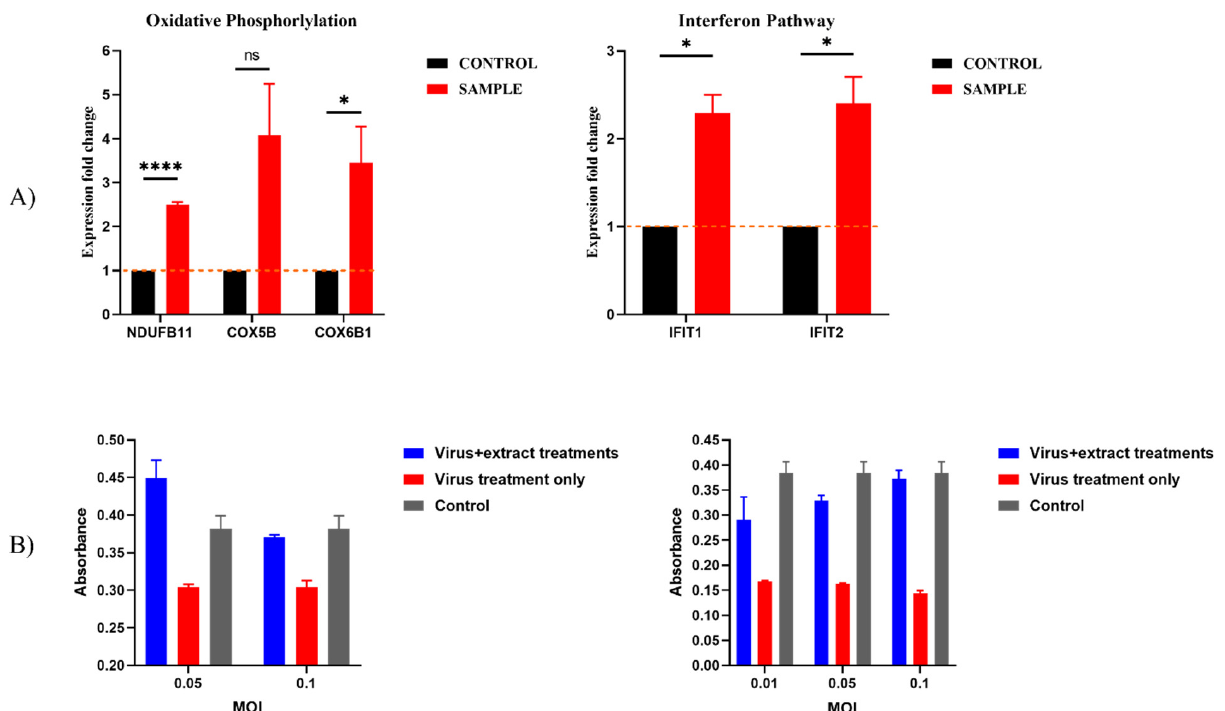
Figure 4. Sarcopoterium spinosum L. extract activates the anti-viral response. ( A ) Real-Time PCR measurement of mitochondrial (NDUFB11, COX5B, COX6B1) and γ -interferon-induced genes (IFIT1, IFIT2). *, p < 0.05; **** p < 0.001 (treated (sample) vs. control). ( B ) The extract protects from the SARS-CoV-2 infection. Cells were pretreated with extract for 4 h, then SARS-CoV-2 virus was added to the cells, cell viability was measured by the MTT assay after 48 h. On the right viability of VERO6 cells, on the left viability of A549 cells have been described. Black—untreated control, Red—virus treatment only, Blue—virus + extract treatments.